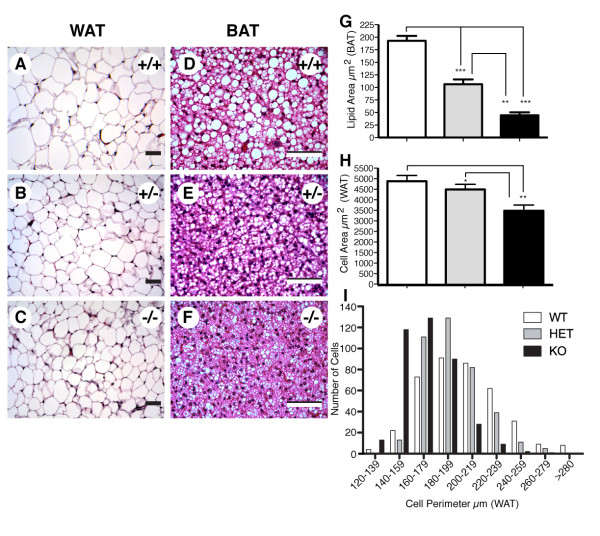
Lipid deposition in multilocular cells of brown adipose tissue (BAT) and unilocular cells of white adipose tissue (WAT) is reduced in VGF knockout mice. Representative sections of epididymal WAT (A-C) and interscapular BAT (D-F) from ad lib-fed, age-matched VgfR +/+ (A, D), +/- (B, E) and -/- (C, F) were stained with H&E. Adipocytes in interscapular BAT and epididymal WAT from -/- mice (C and F) contain less lipid accumulation than the corresponding adipocytes from wild type mice (A and D). Scale bars are 50 μm in length. Morphometric analysis of adipose tissue from VgfR +/+, +/-, and -/- mice was carried out using MetaMorph, as detailed in Materials and Methods. Lipid area in BAT (panel G), cell area in WAT (panel H), and the distribution of adipocyte perimeters in WAT (panel I), were quantified for each genotype. Note the significant reduction in lipid area in both +/- and -/- BAT (ANOVA, F (2,15) = 73.5, p < 0.0001), significant reduction in adipocyte area in -/- WAT (ANOVA, F (2,15) = 7.6, p = 0.005), and shift in the distribution of cells favoring those with significantly smaller perimeters in -/- and +/- WAT (comparison of mean perimeters in μm; ANOVA, F (2,1167) = 166, p < 0.0001), compared to wild type. Values are mean ± SEM, *p < 0.05, **p = 0.005, ***p < 0.0001 compared to wild type (ANOVA and Bonferroni's posthoc test).